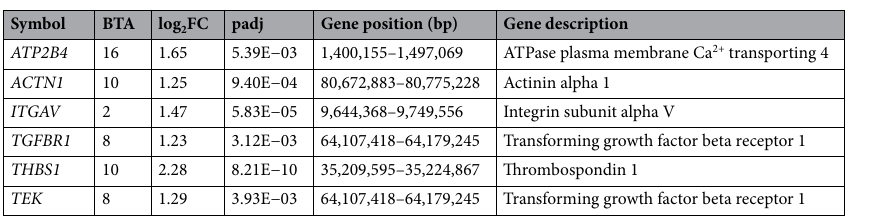
Table 5. Six potential candidate genes affecting the WHC between two groups. WHC water holding capacity, BTA Bos taurus autosome, FC fold change, padj p-value adjusted by false discovery rate (FDR). Gene position (bp): position (bp) on